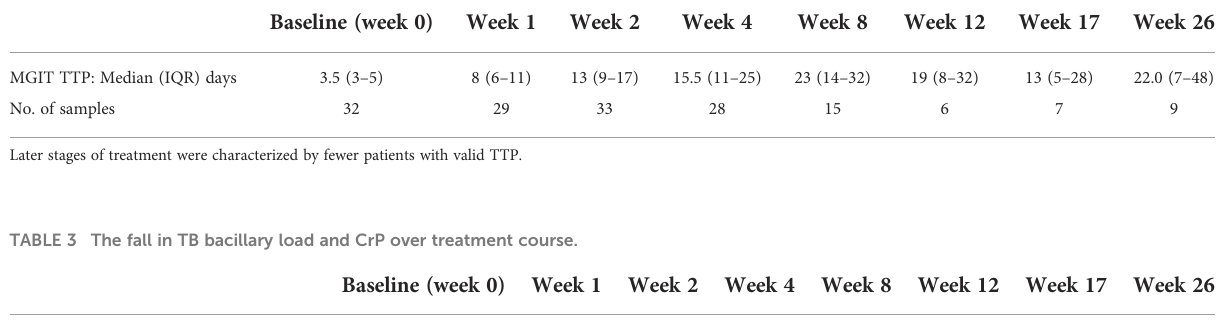
TABLE 2 MGIT TTP result from baseline to week 26 of treatment.